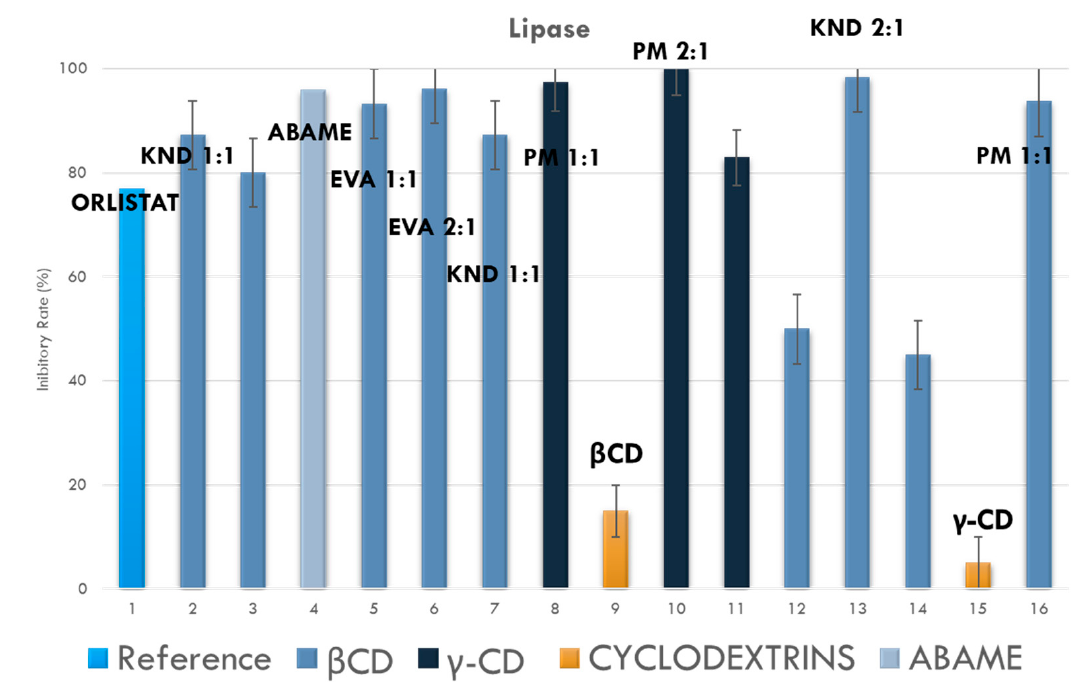
Figure 10. Rate of inhibition of lipase activity (%) exerted by different samples at a concentration of 1 µg mL − 1 . Data, worked out by the statistical software GraphPad Prism (version 6.0), are expressed as means ± SD. p < 0.05 was considered statistically significant when compared to the control group.